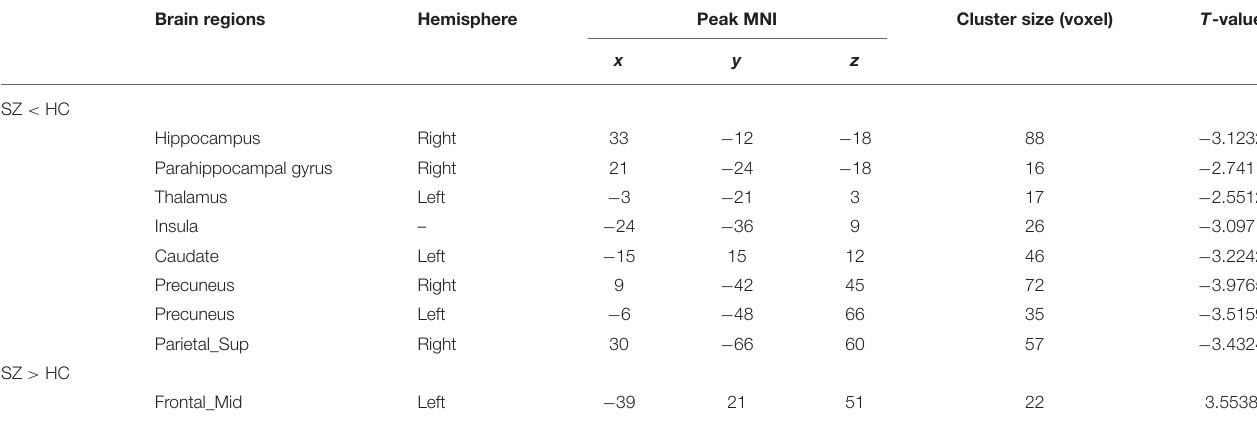
TABLE 2 | Altered regions of left SFG FC based on the ROI analysis between youth-onset schizophrenia and HC. Brain regions